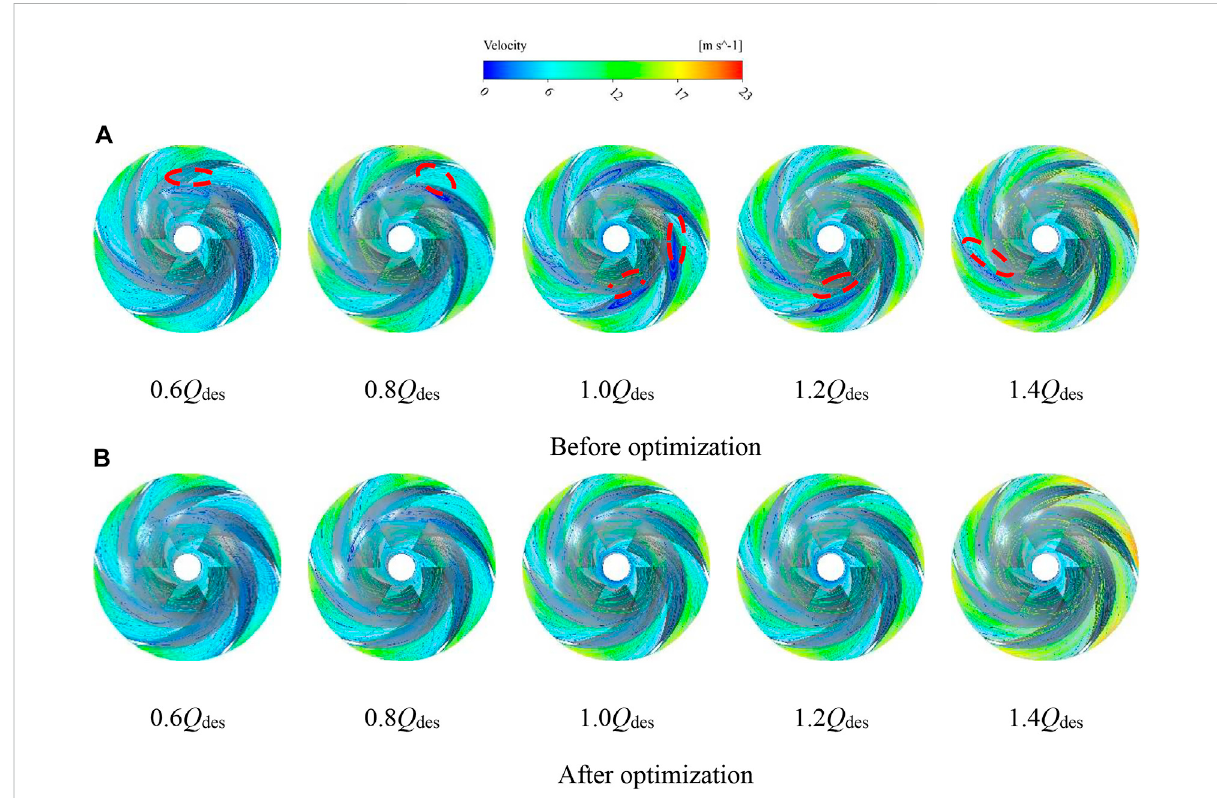
FIGURE 13 Velocity streamline diagram in impeller under different working conditions before and after optimization. (A) before optimization (B) after